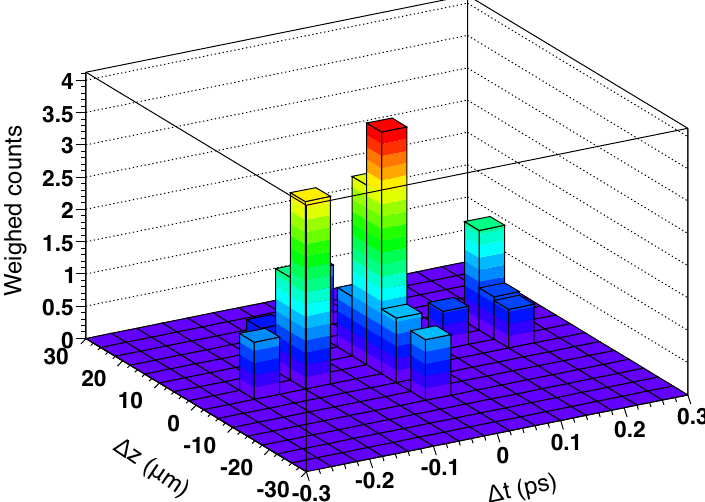
Figure 4. Signal intensity distribution obtained in the experiment. ∆ t and ∆ z denote the time and vertical position differences between the two laser